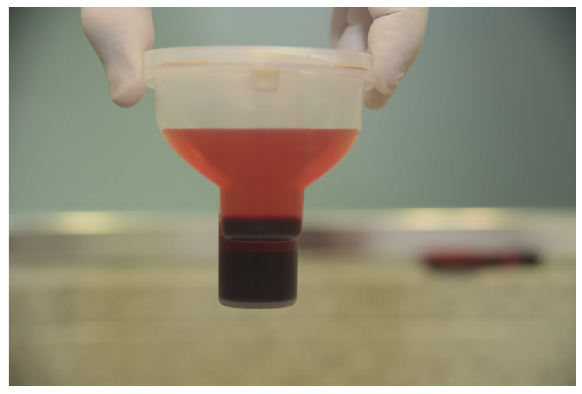
Figure 3: After centrifugation for 14 minutes, two phases were obtained within the container: (1) the supernatant plasma above and (2) precipitated bone marrow cells concentrate below.